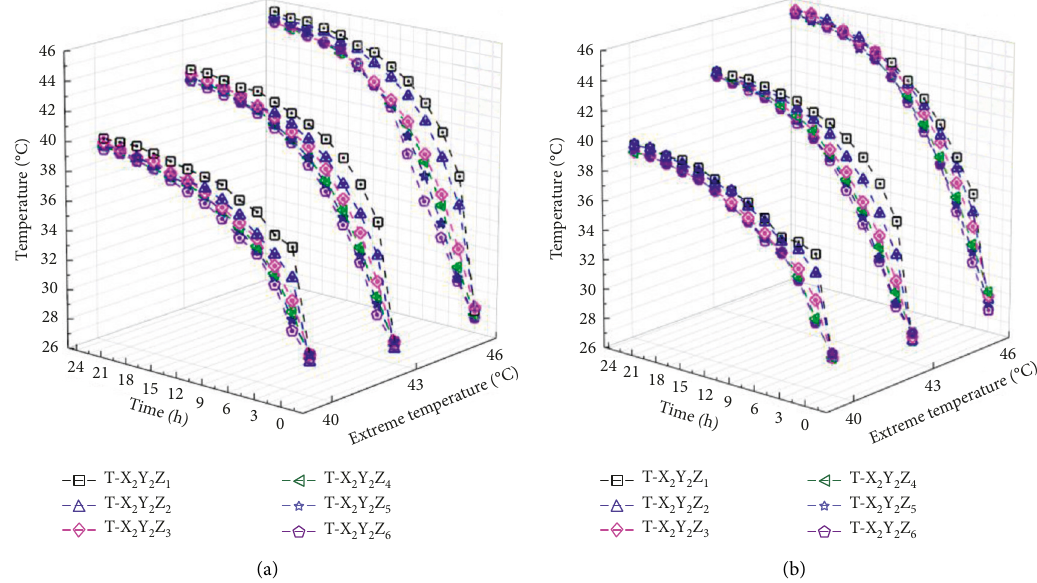
Figure 5: Temperature-time curves of the scaled specimen: (a) temperature-time curve of the constraint specimen and (b) temperature-time curve of the freedom